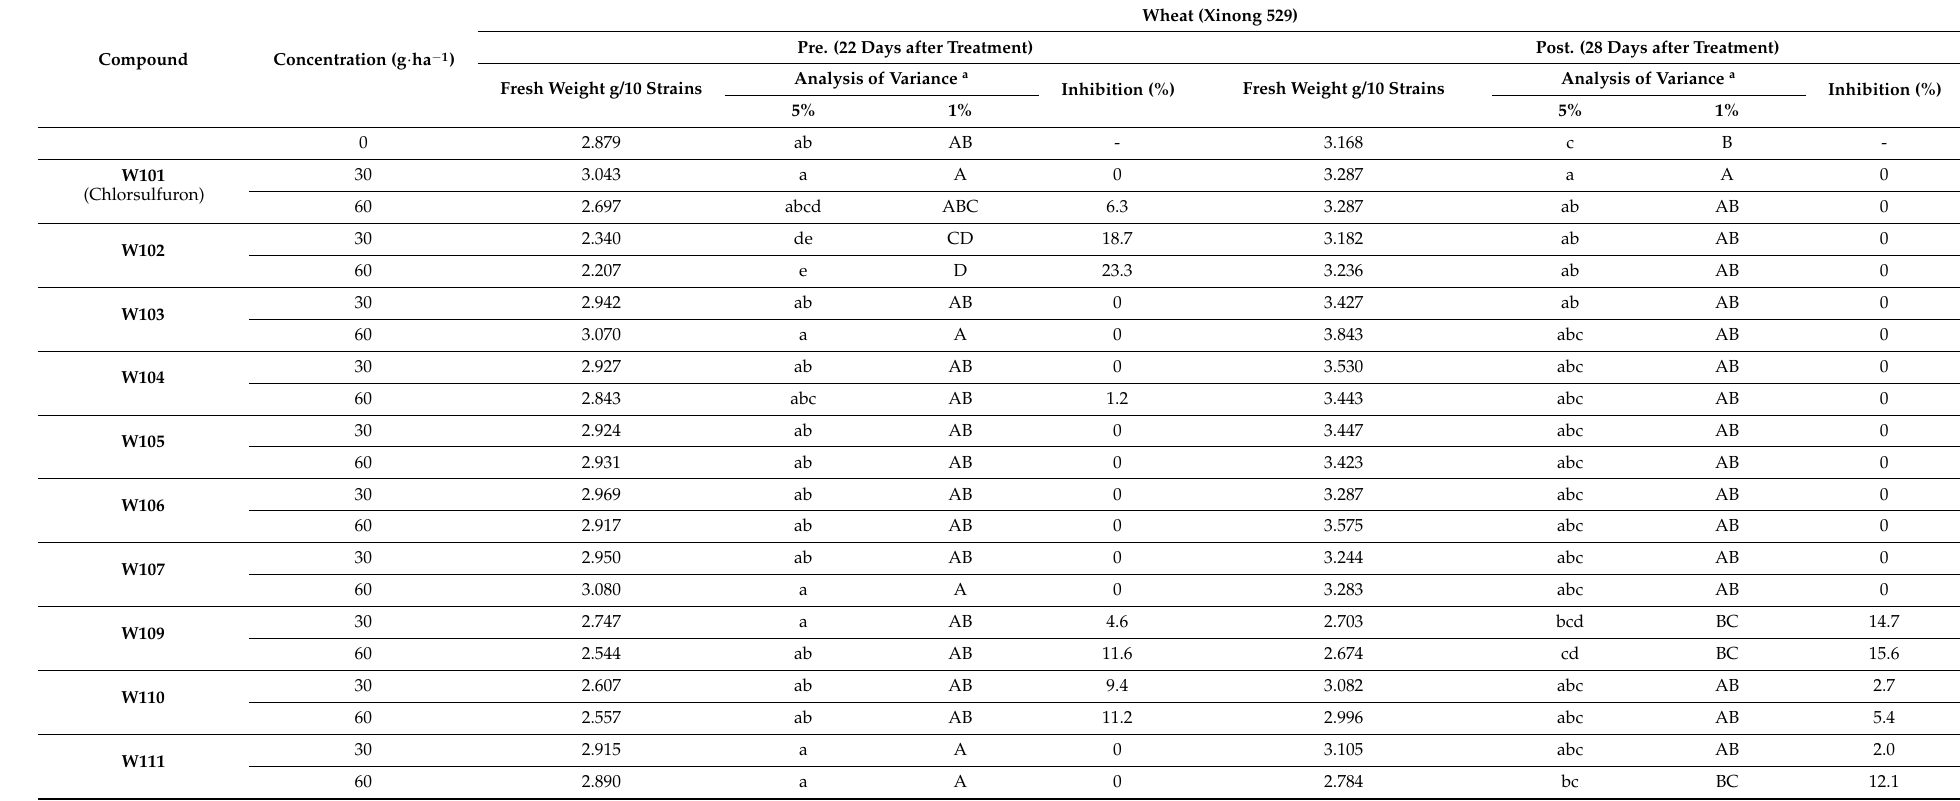
Table 5. Crop safety of target compounds on